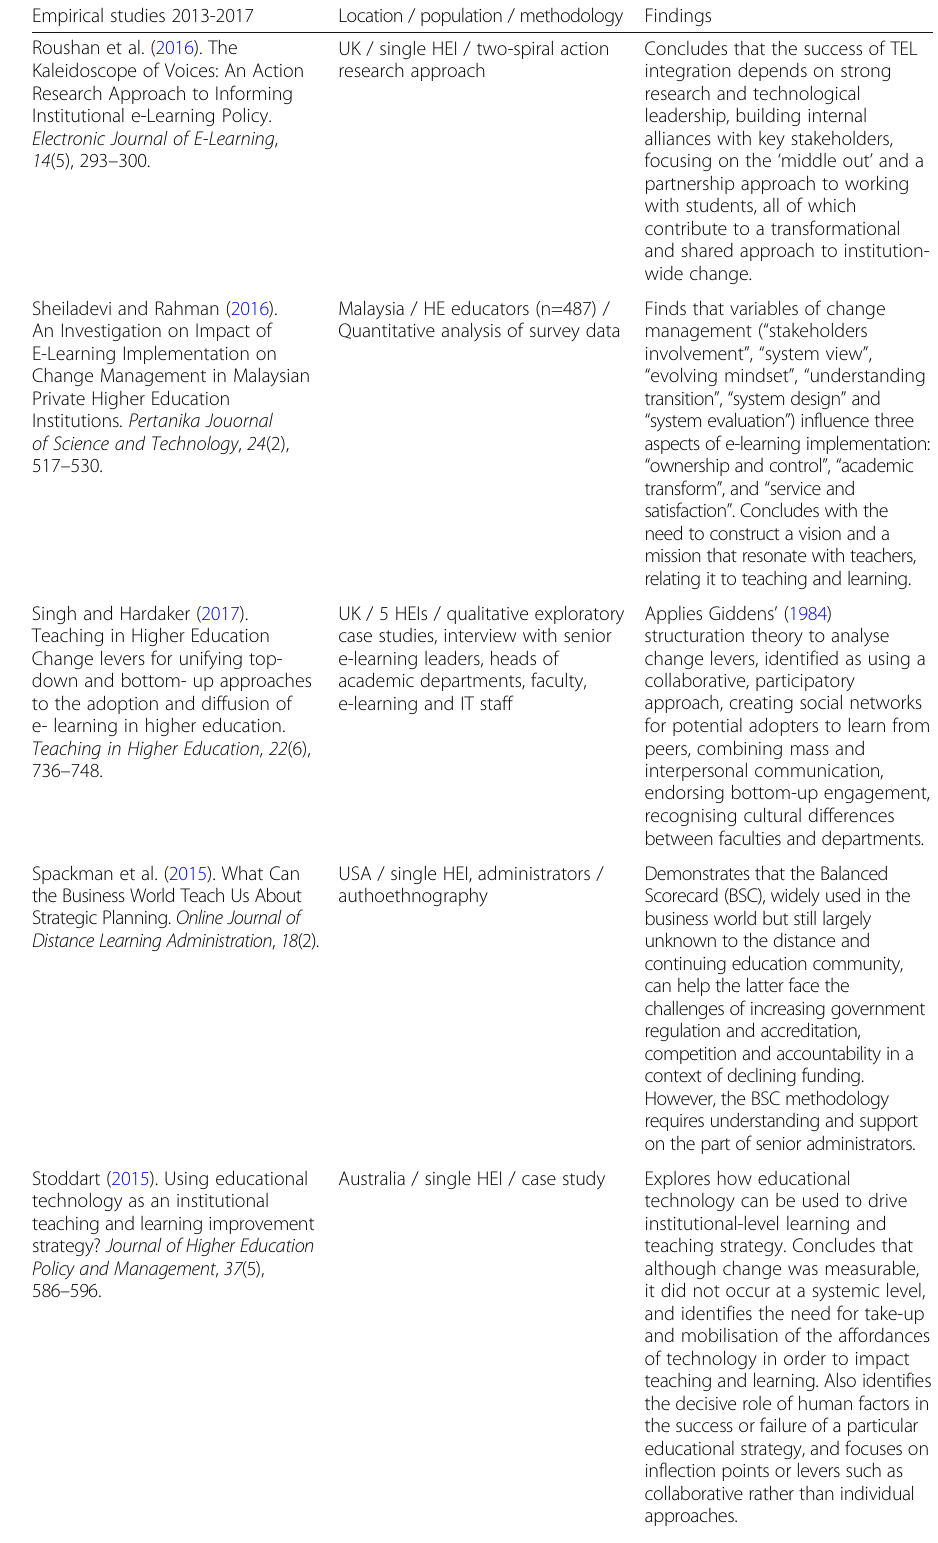
Table 2 Results: Empirical studies (Continued) Empirical studies